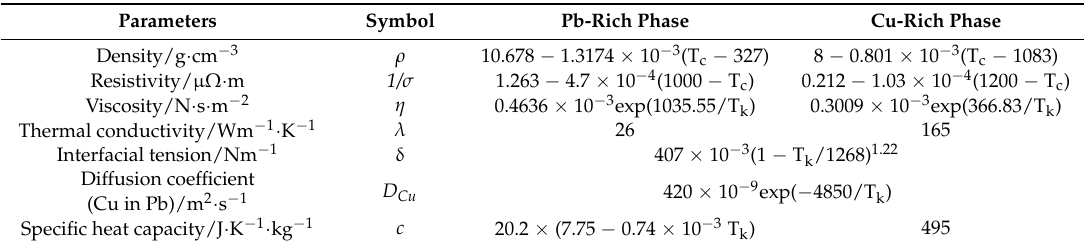
Table 1. Thermophysical parameters used for the simulation